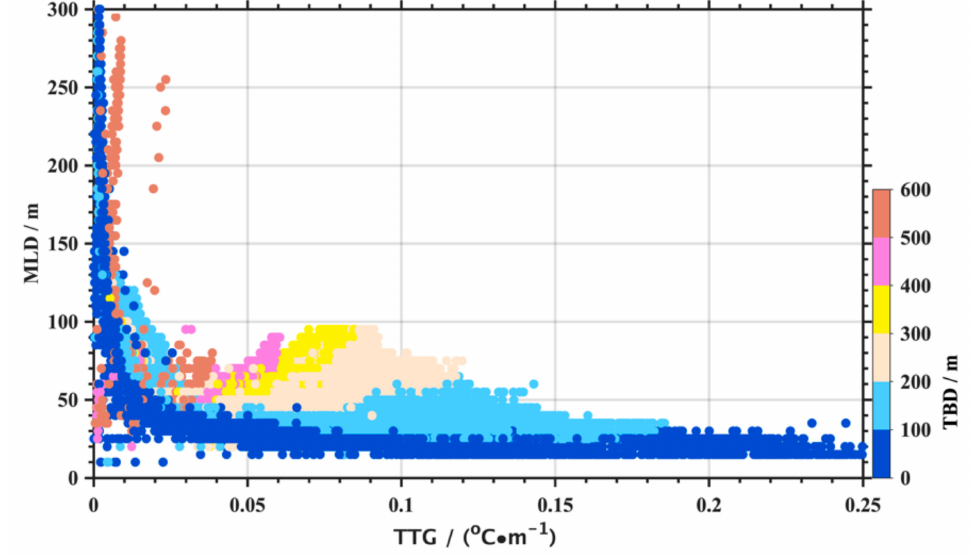
Figure 11. Scatter correlation scheme of the parameters TTG and MLD of the annual thermocline, with the corresponding TBD in the global